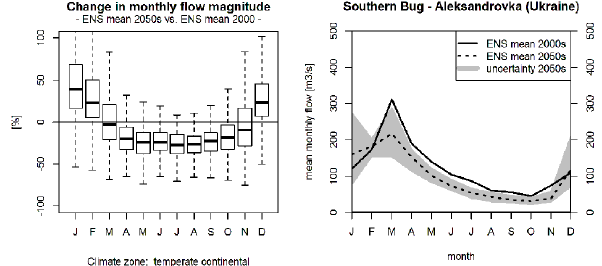
Fig. 10. Direction of change in the 2050s plotted for all grid cells of the temperate continental climate zone (left) and the Southern Bug river near Aleksandrova (right).